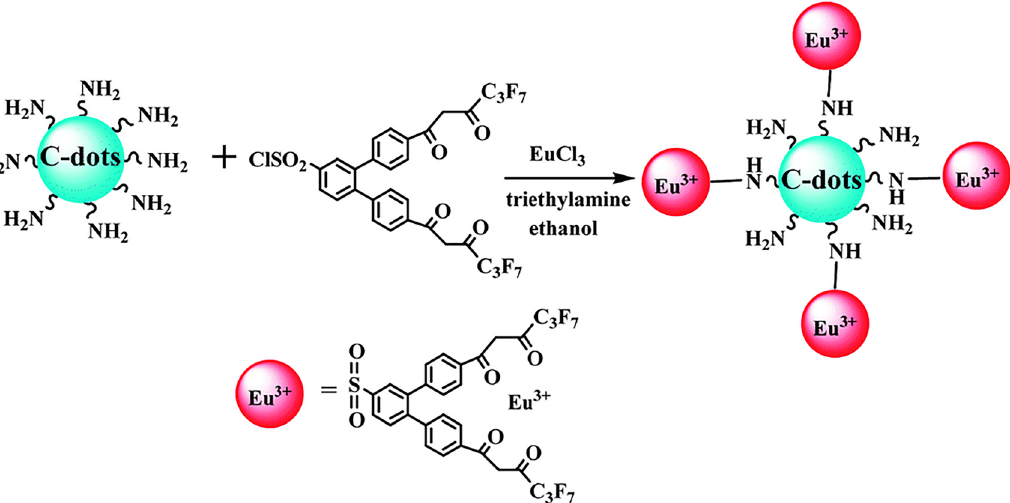
Figure2: Preparationofcarbondots(CDs)-BHHCT-Eu(III)dual-fluorophoresystem.ReprintedfromTanetal.workswiththekindpermissionof The Royal Society of Chemistry [93]. Copyright (2014) The Royal Society of